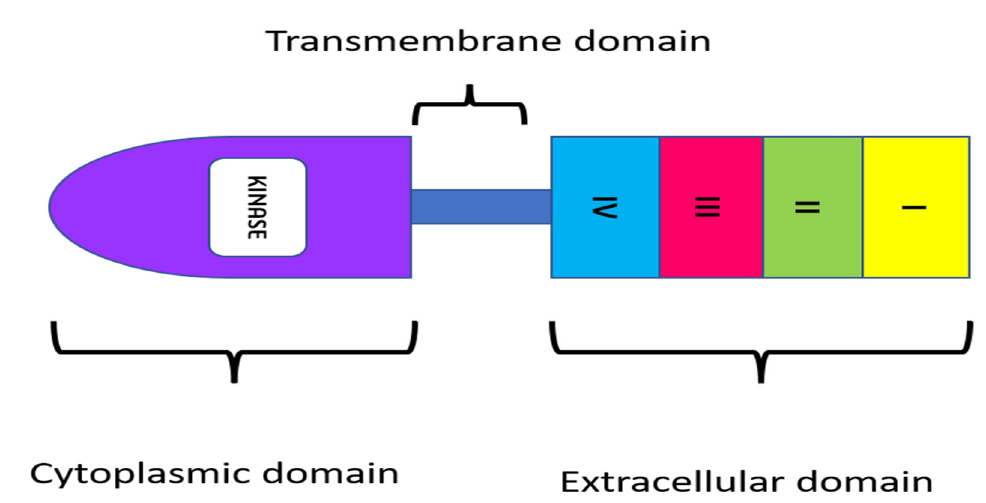
Figure 2. Structure of EGFR receptor.